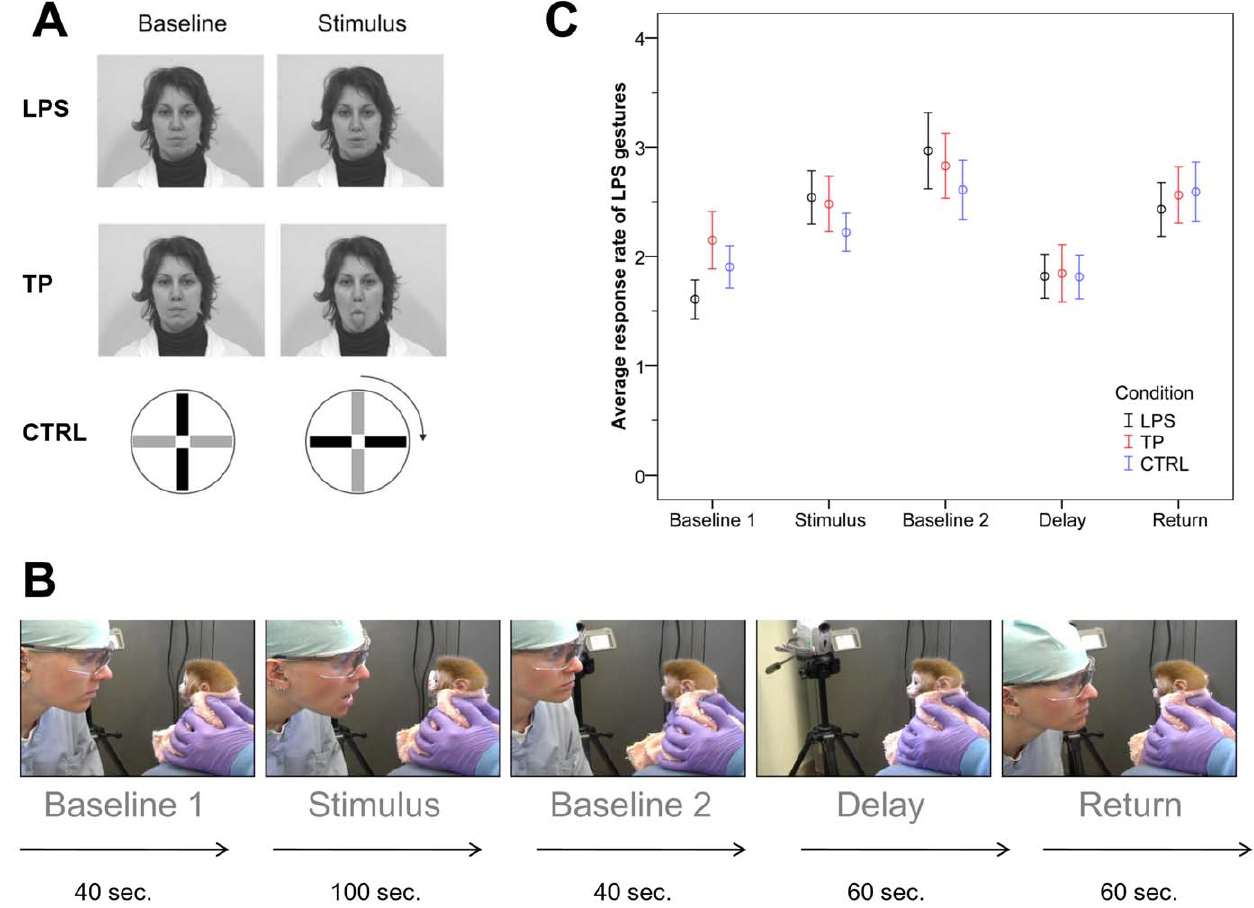
Figure 1. Illustration of the experimental conditions and LPS responses for all infants. A. Illustration of modeled gestures. LPS: lipsmacking. TP: tongue protrusion. CTRL: control condition in which a disk was presented in front of the infant during the baseline period. During the stimulus period, the disk was rotated both clock and counter-clockwise. B. Illustration of an example LPS trial with durations of each phase. C. Average response rates of LPS per 40 sec + / 2 SEM in LPS, TP, and CTRL conditions for all infants (N=60) across time